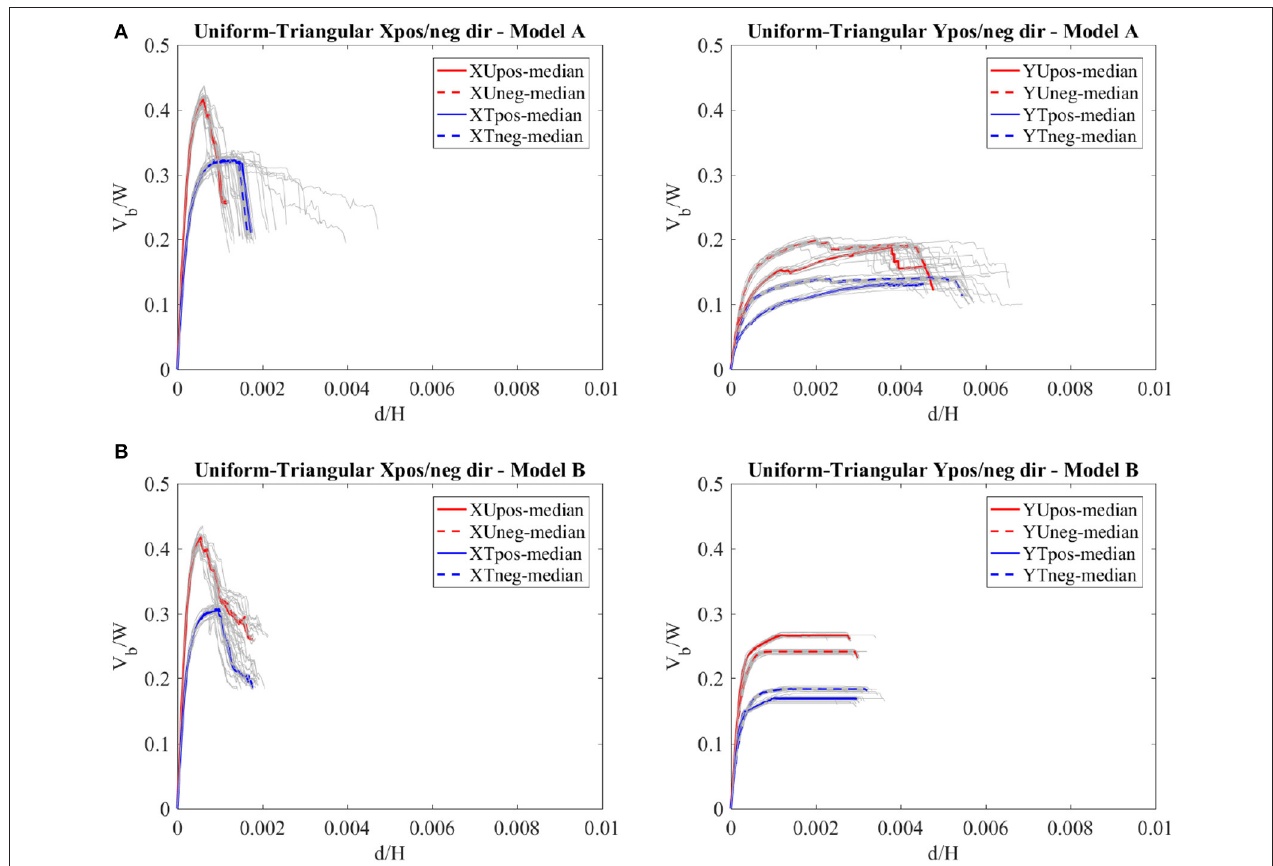
FIGURE 9 | Pushover curves: (A) Model A; (B) Model